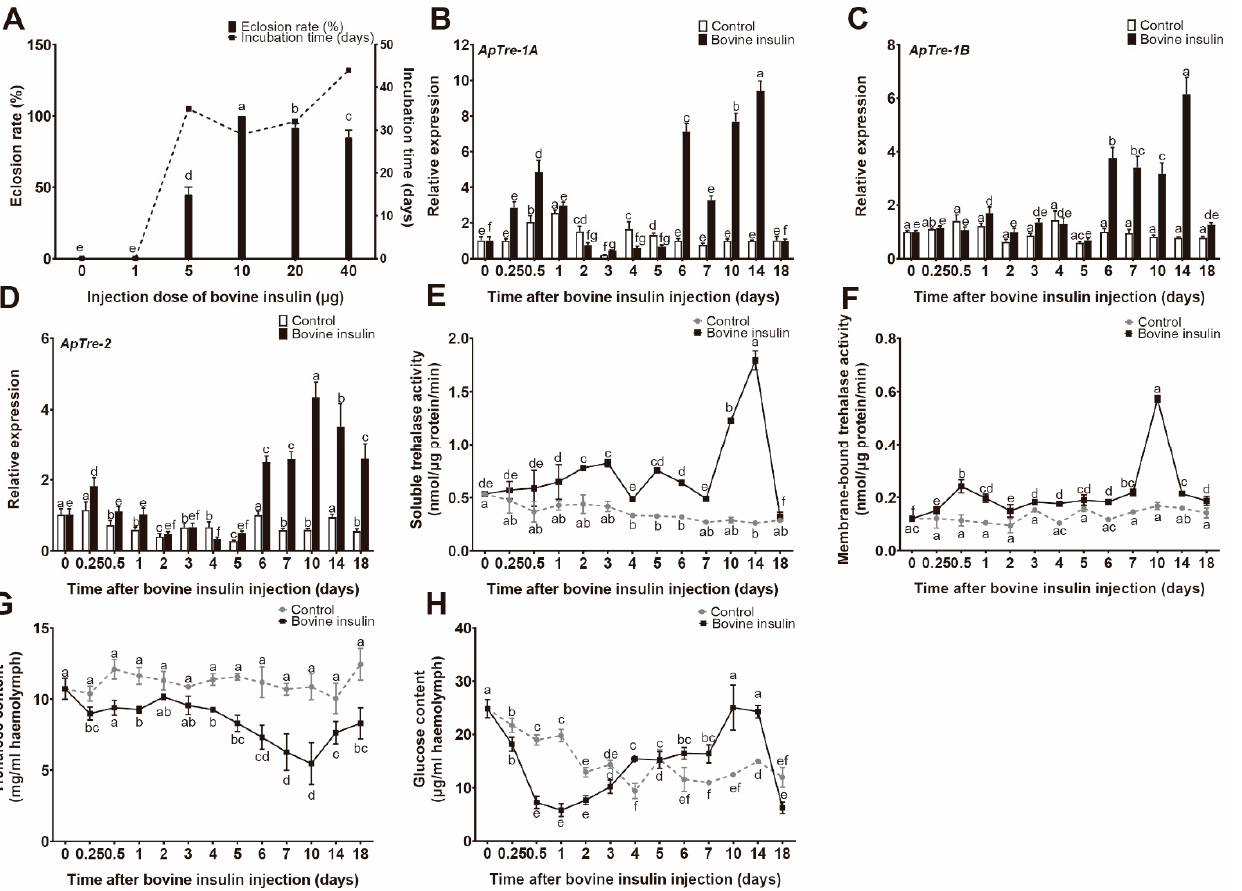
Figure 2. Bovine insulin injection induced diapause termination and enhanced trehalose catabolism in A. pernyi diapausing pupae. ( A ) Effect of different doses of bovine insulin on breaking the diapause of A. pernyi pupae. Diapausing pupae were exposed to a short-day photoperiod of L:D 9:15 at 25 ◦ C after bovine insulin injection. Eclosion rates were recorded. Each group consisted of 20 individuals, and error bars indicate the mean ± SE of three replicates. ( B – D ) Relative expression levels of ApTre-1A , ApTre-1B , and ApTre-2 , respectively, induced by bovine insulin injection. The mRNA levels were normalised to the reference genes actin and RP49 , and pupae treated with PBS buffer served as controls (CK). The mRNA levels of ApTres in pupae before treatment (0 h) were defined as 1. ( E , F ) Changes in soluble and membrane-bound trehalase activity, respectively, caused by bovine insulin injection. ( G , H ) Influence of bovine insulin treatment on haemolymph trehalose and glucose levels, respectively. The dotted lines represent the control group (which received PBS buffer), while the solid lines represent the bovine-insulin-treated group. Data are means of three independent experiments, and error bars are SEs. Different letters above the error bars indicate significant differences at p <